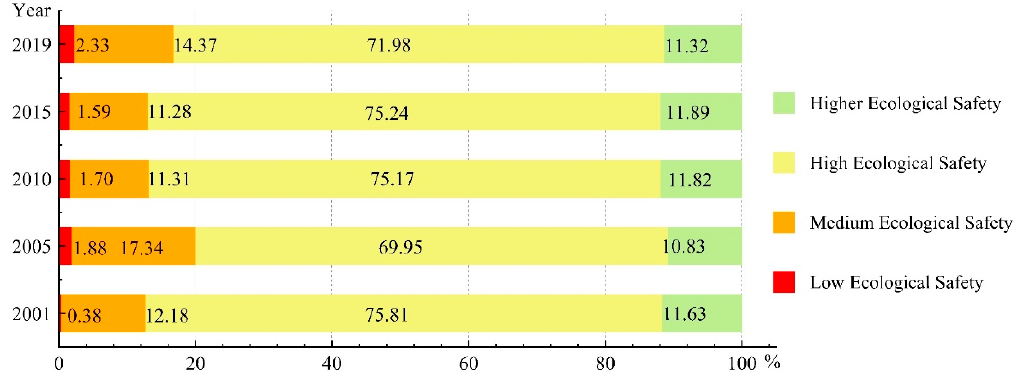
Figure 4. Proportions of areas with different ES levels in the HRB.